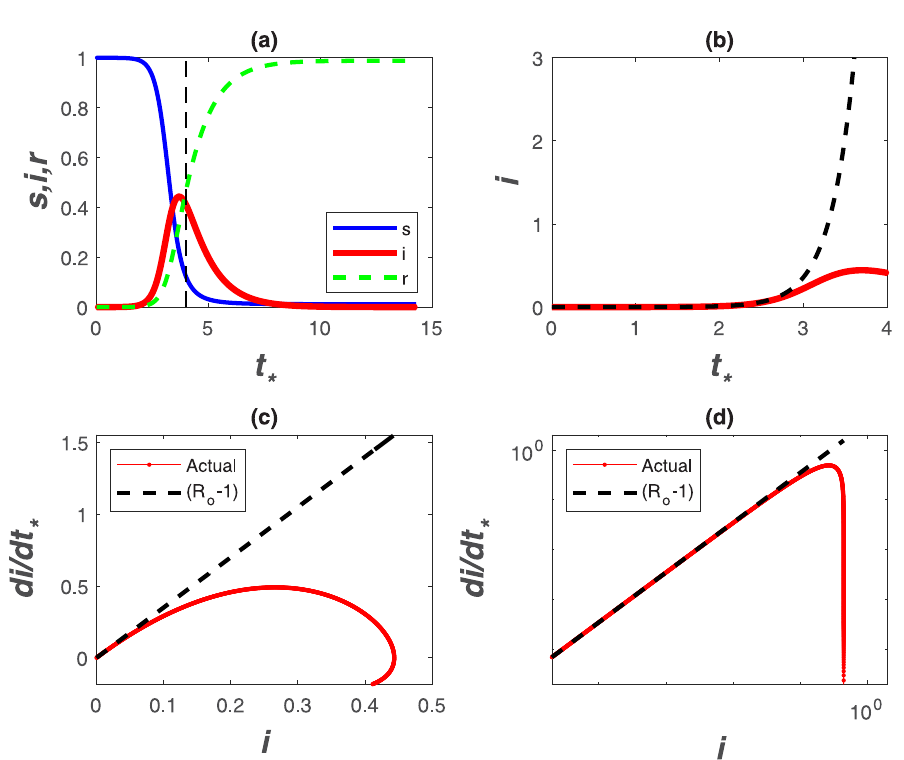
Fig 2. Phase space and temporal trends of the SIR model. (a) S ( t ), I ( t ), R ( t ) normalized by S o as a function of dimensionless time t � = γ t with S = 100, 000, γ = (1/14) d − 1 , and R = 4.5. (b) i = I / S in dimensionless time t � = γ t for o o o early times t � < 1 revealing strictly exponential growth (dashed) and deviations from exponential (SIR solution). (c) di / dt � with i in linear and (d) double-log representations. The dashed line is ( R o − 1) where R o = 4.5. Declines from the dashed line reflect the incipient point where i ( t ) deviates appreciably from exponential growth. Note how the early- time slope ( R o − 1) is emphasized in the double-log